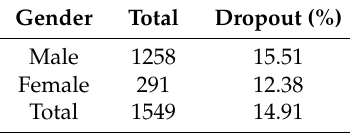
Table 2. Gender and the corresponding number of observed samples and dropout percentage.